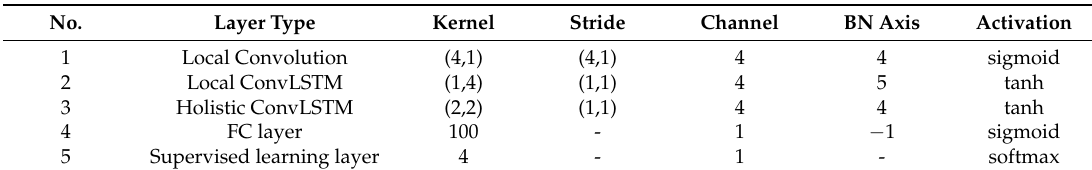
Table 2. Parameters of the proposed model used in gearbox fault diagnosis experiments.